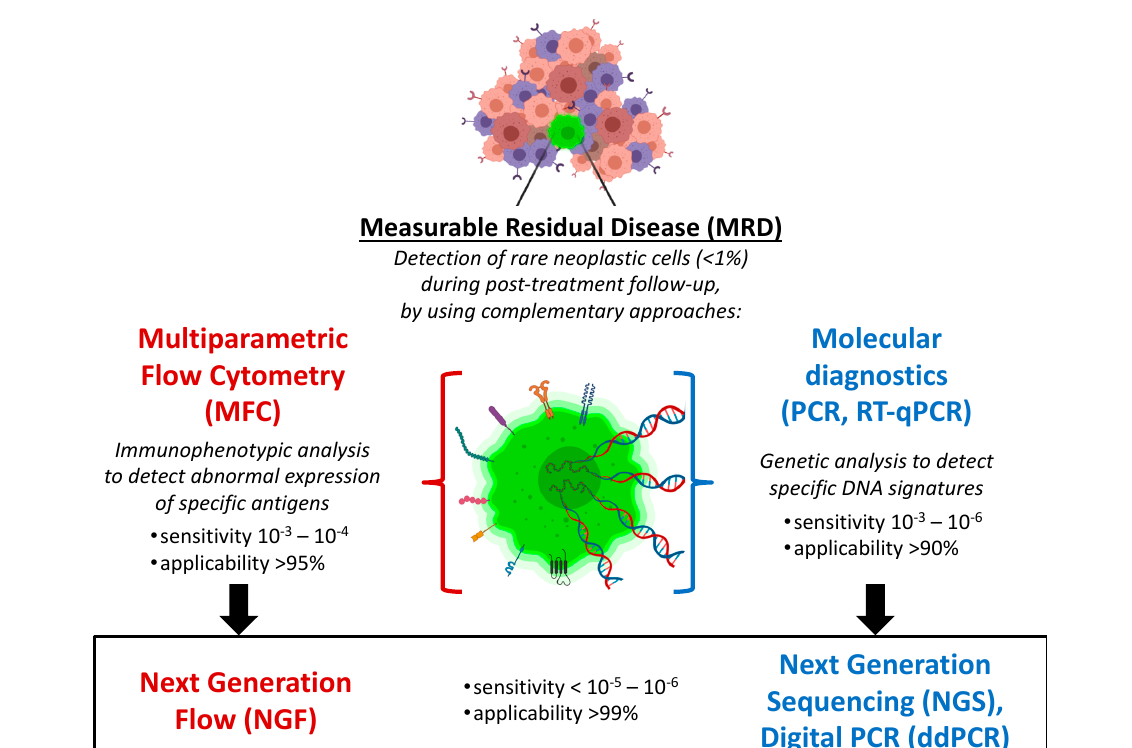
Figure 1. Complementary immunophenotypic and molecular approaches for hematologic MRD monitoring. MRD has widely emerged as the main post-treatment prognostic factor in different hematologic malignancies. Recent high-throughput evolutions of such advanced diagnostics are pushing forward the sensitivity, applicability and reproducibility of MRD detection, thus fostering new valuable integrations with clinical management and, in particular, with novel immunotherapeutic strategies.